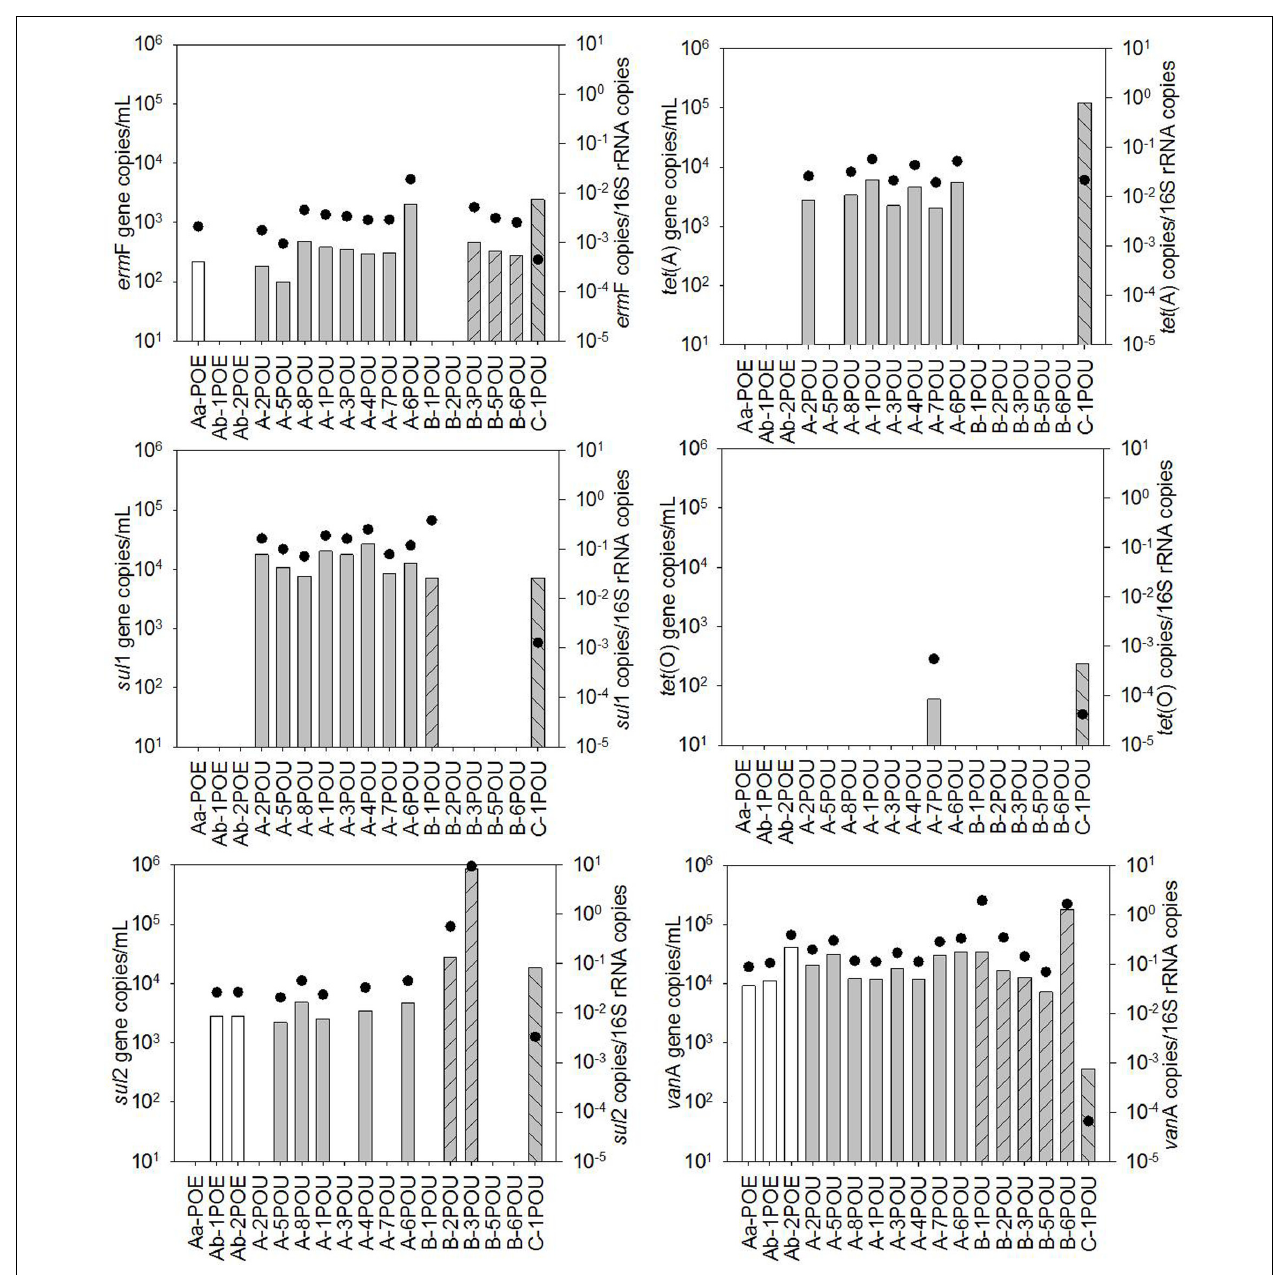
FIGURE 1 |Absolute (bars) and 16S rRNA gene-normalized (symbols) levels ofARGs in water samples collected at point of entry (POE) forWWTPsAa andAb and at point of use (POU) for systemsA, B, and C, numbers differentiate between sample locations.